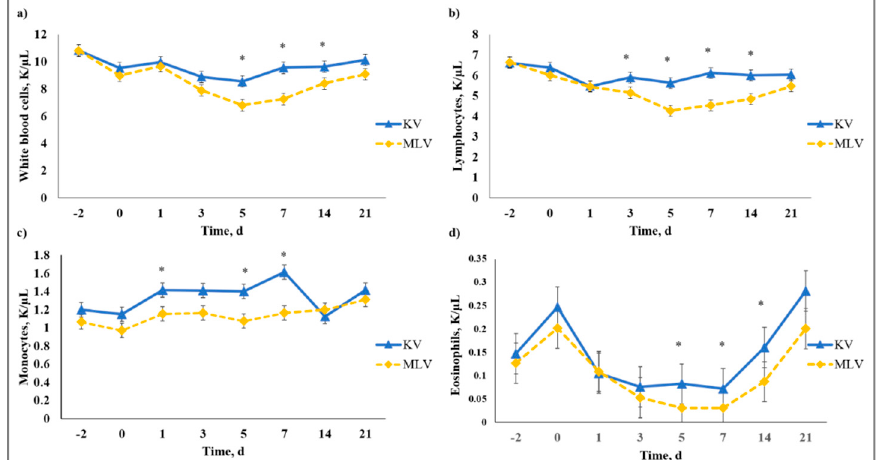
Figure 9. Effect of killed virus (KV; Triangle 5; Boehringer Ingelheim Animal Health, Inc. (BIAH)) and modified-live virus vaccination (MLV; Pyramid 5; BIAH) on: ( a ) white blood cells (WBC); ( b ) lymphocytes (LYM); ( c ) monocytes (MONO); and ( d ) eosinophils (EOS) after subcutaneous injection of multivalent respiratory vaccine on Day 0. Effect of vaccination on WBC (vaccine treatment × day effect; p < 0.01); LYM (vaccine treatment × day effect; p < 0.01); MONO (vaccine treatment × day effect; p < 0.01); EOS (vaccine treatment × day effect; p < 0.01). * KV differs from MLV within day, p ≤ 0.04.